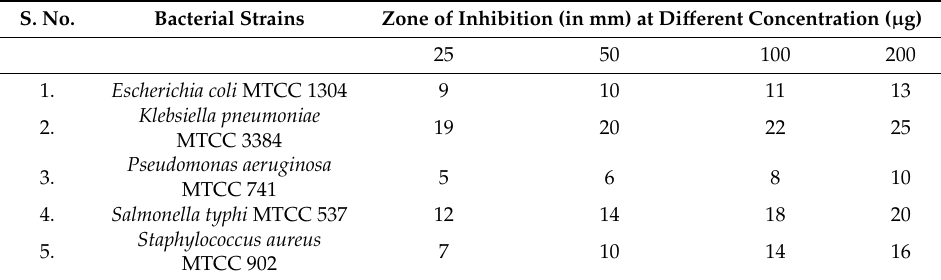
Table 3. Activity of zinc oxide nanoparticle against di ff erent bacterial strains. S.